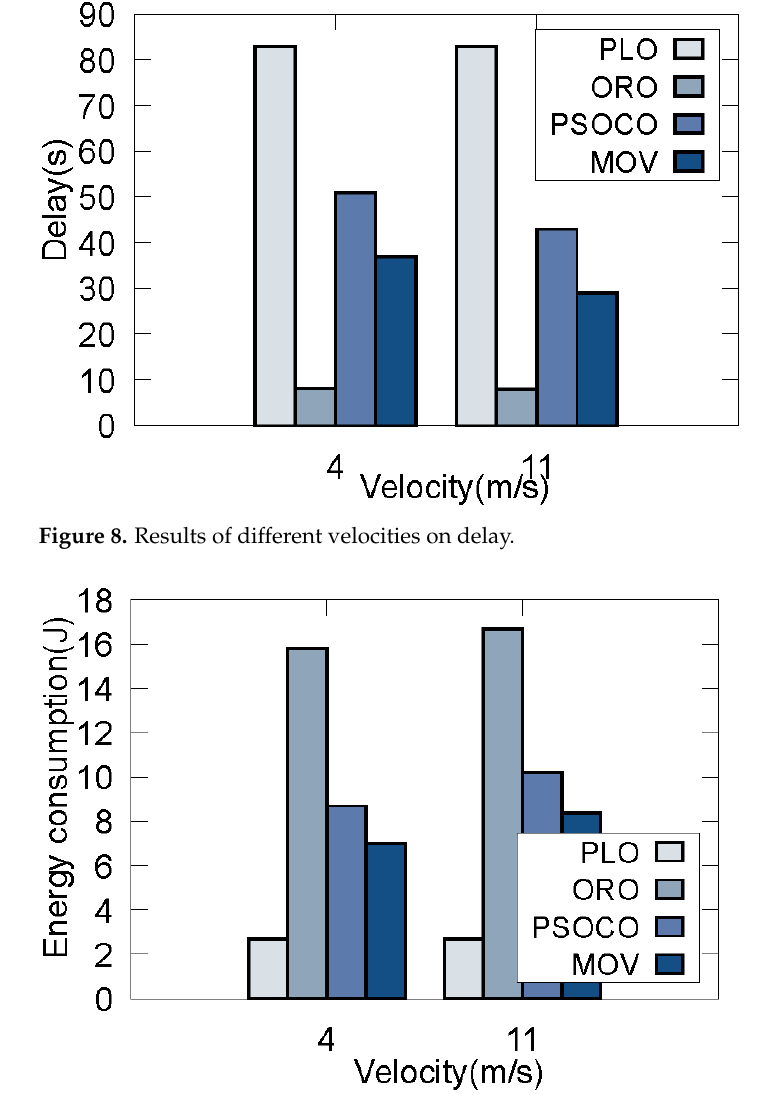
Figure 9. Results of different velocities on energy